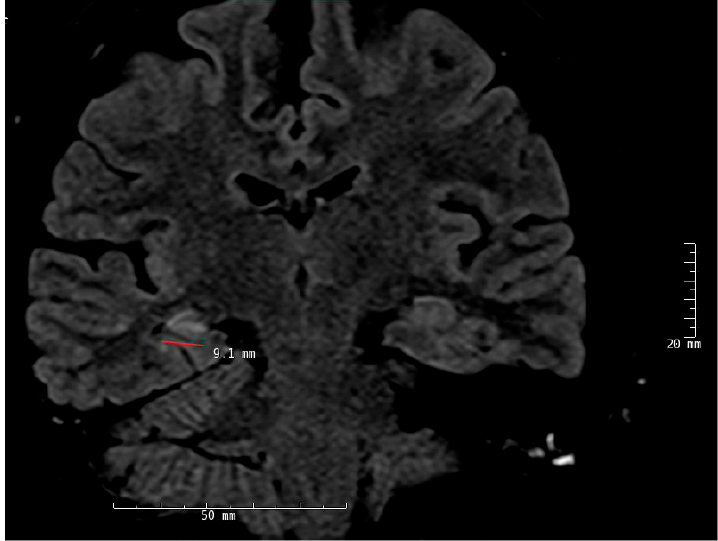
Figure 2. Right mesial temporal sclerosis (MTS). There is atrophy and increased signal intensity in the CA1-3 regions of the right hippocampus. Coronal view; fluid-attenuated inversion recovery (FLAIR)